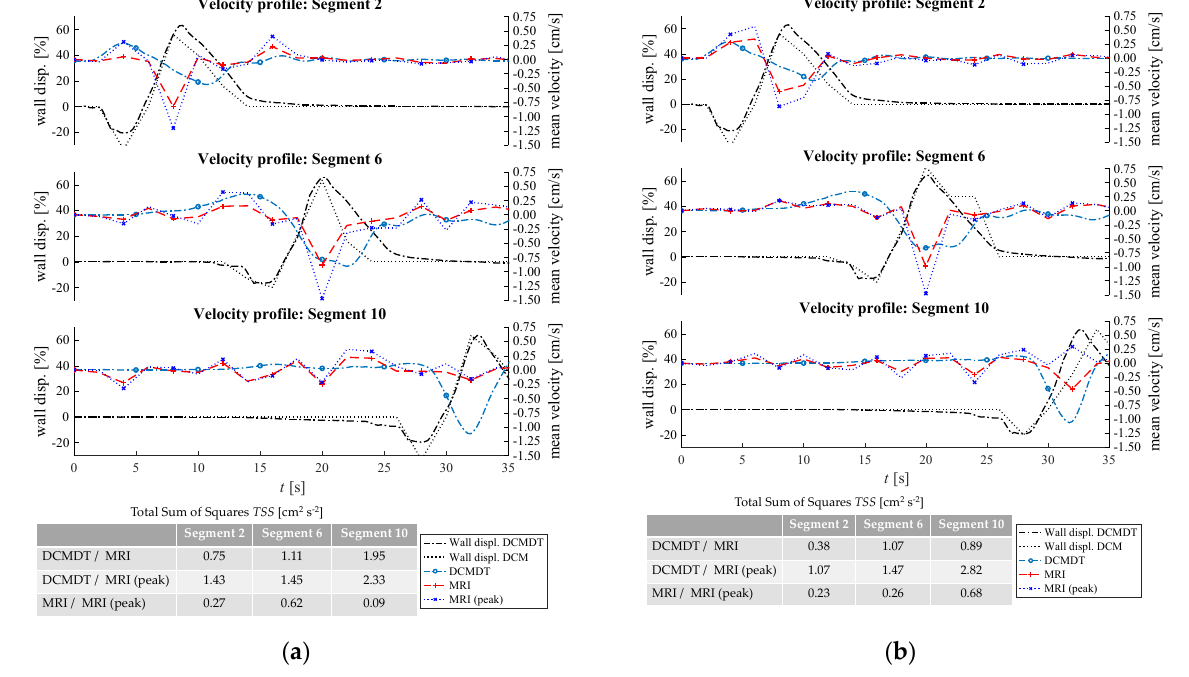
Figure 10. Comparison of the fluid velocities and wall displacement profiles of the DCM and the DCMDT at low fluid volume and fast propagating PPW. In ( a ) the mean fluid velocities at low fluid viscosity and in ( b ) the mean fluid velocities at high fluid viscosity are compared. The experimental data shown in Figure 10a segment 2 and segment 6 and Figure 10b